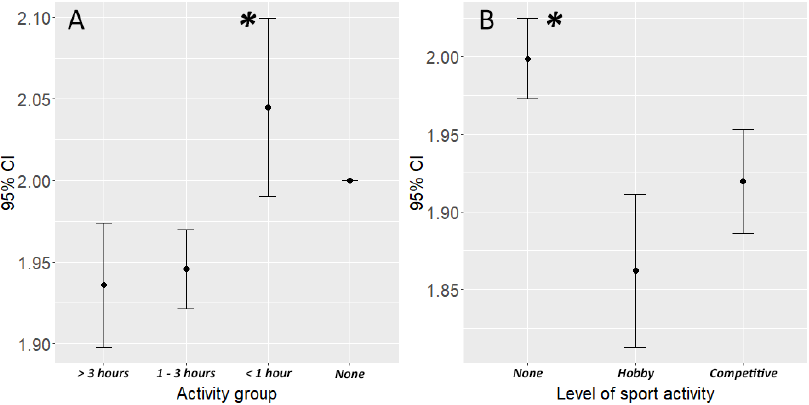
Figure 2. The associations between daily activity and sport activity with the body condition of the dogs. ( A ) Dogs that spent at least one hour a day actively with their owners were less likely to be overweight and ( B ) dogs that are engaged in sports were less likely to be overweight. Asterisk denotes those groups that significantly di ff er from the others ( p <